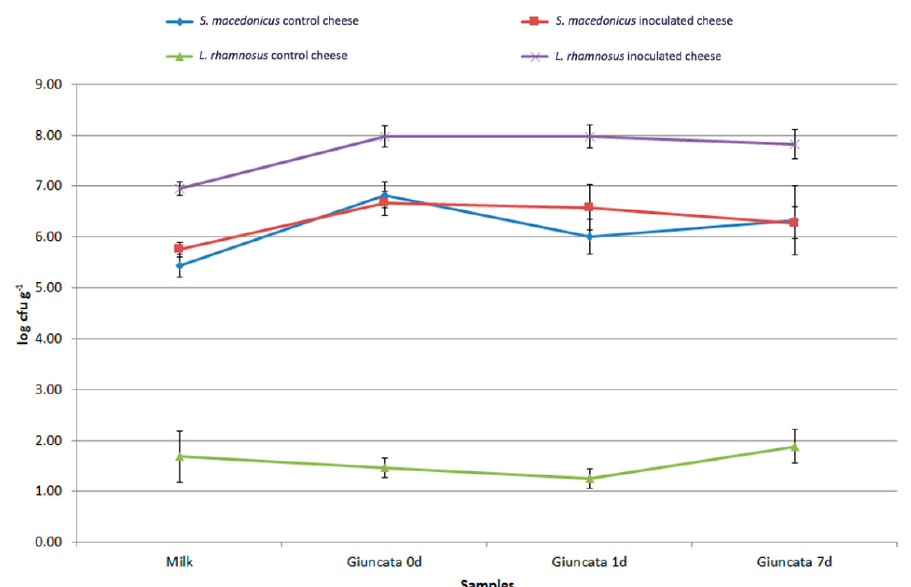
Figure 6. Population dynamics of S. macedonicus and Lactobacillus rhamnosus at di ff erent steps of the production and cold storage of uninoculated and inoculated advanced Giuncata Leccese samples.